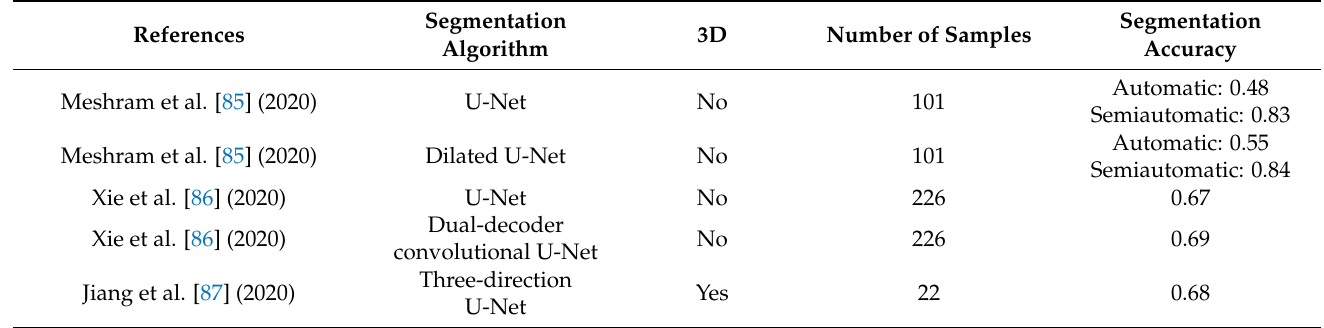
Table 3. Application based on U-Net deep-learning algorithm in carotid atherosclerotic plaque segmentation with US